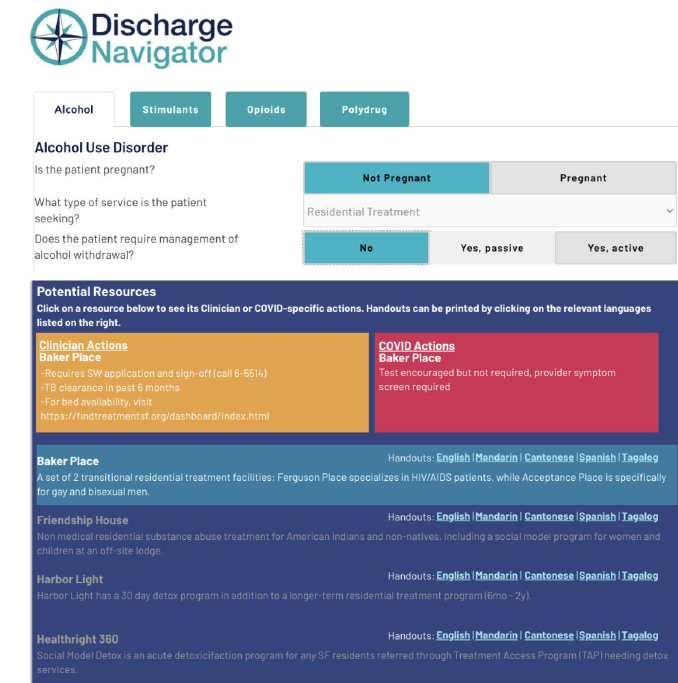
Figure 3. Sample of digital decision tool interface, with inputs and